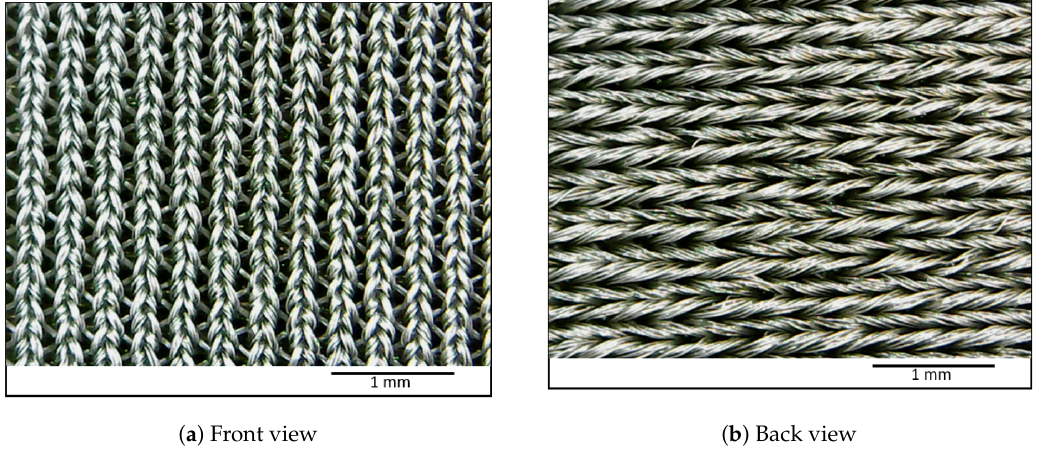
Figure 1. Unstretched fabric as viewed from the front and back